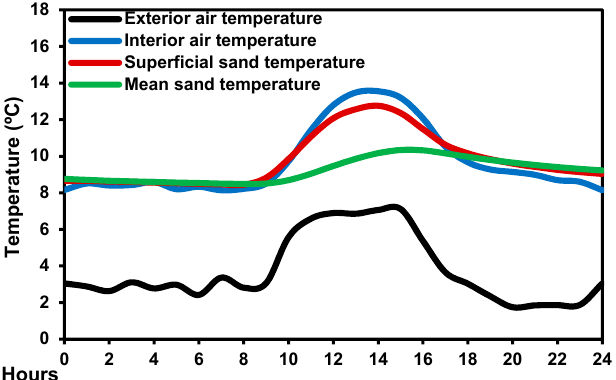
Figure 9. Superficial and mean temperature of the sand, exterior and interior air temperature for the 15th of December.